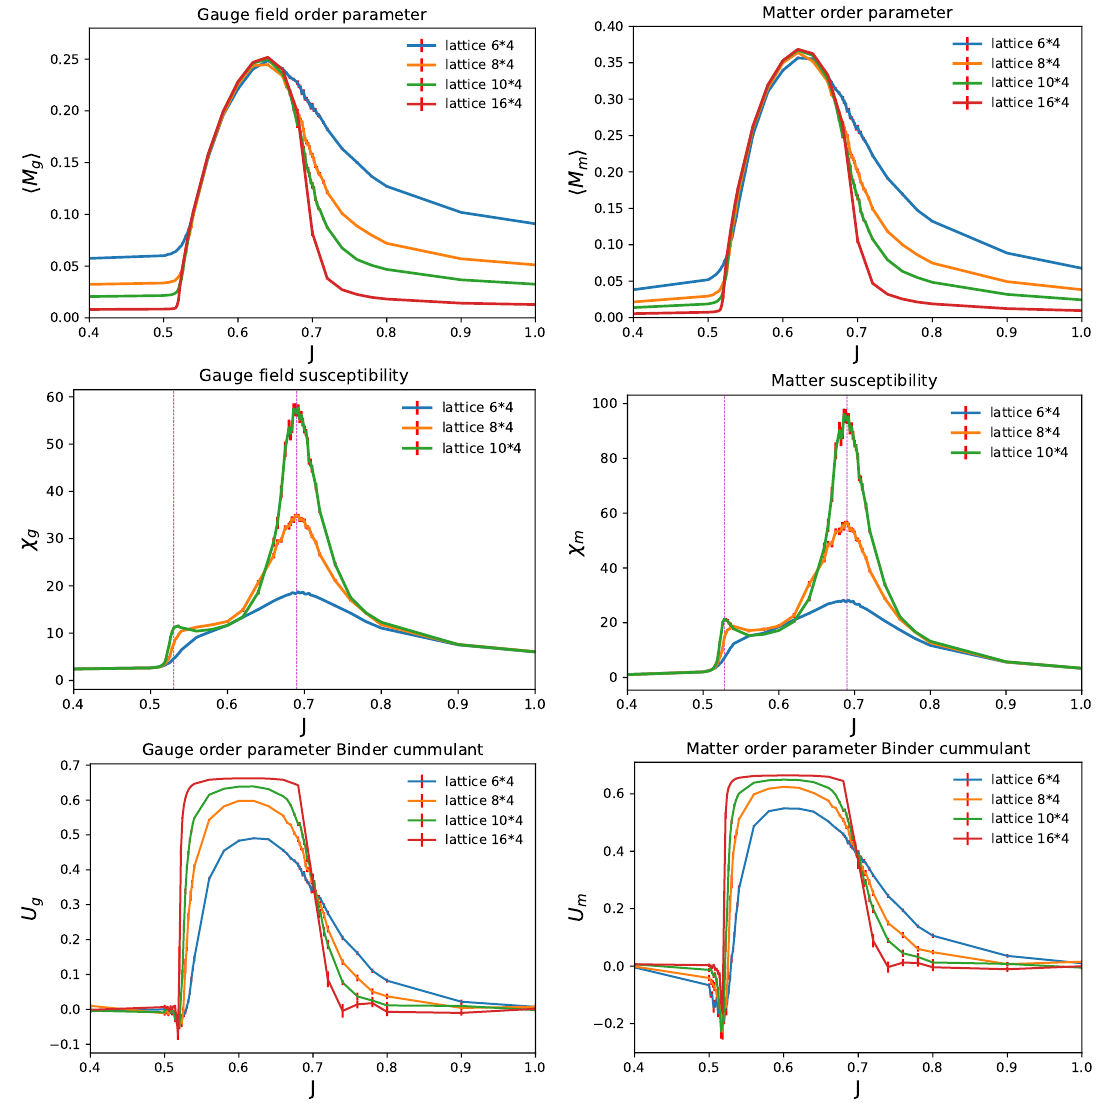
Figure 4 . Vacuum expectation value (top row), susceptibility (middle row) and Binder cumulant (bottom row) for the gauge field order parameter M g (lhs. column) and the matter order parameter M m (r.h.s. column). The results are for the self-dual value β = β ∗ ≡ 1 / 2 π and are plotted as a function of J . We compare different volumes as indicated in the